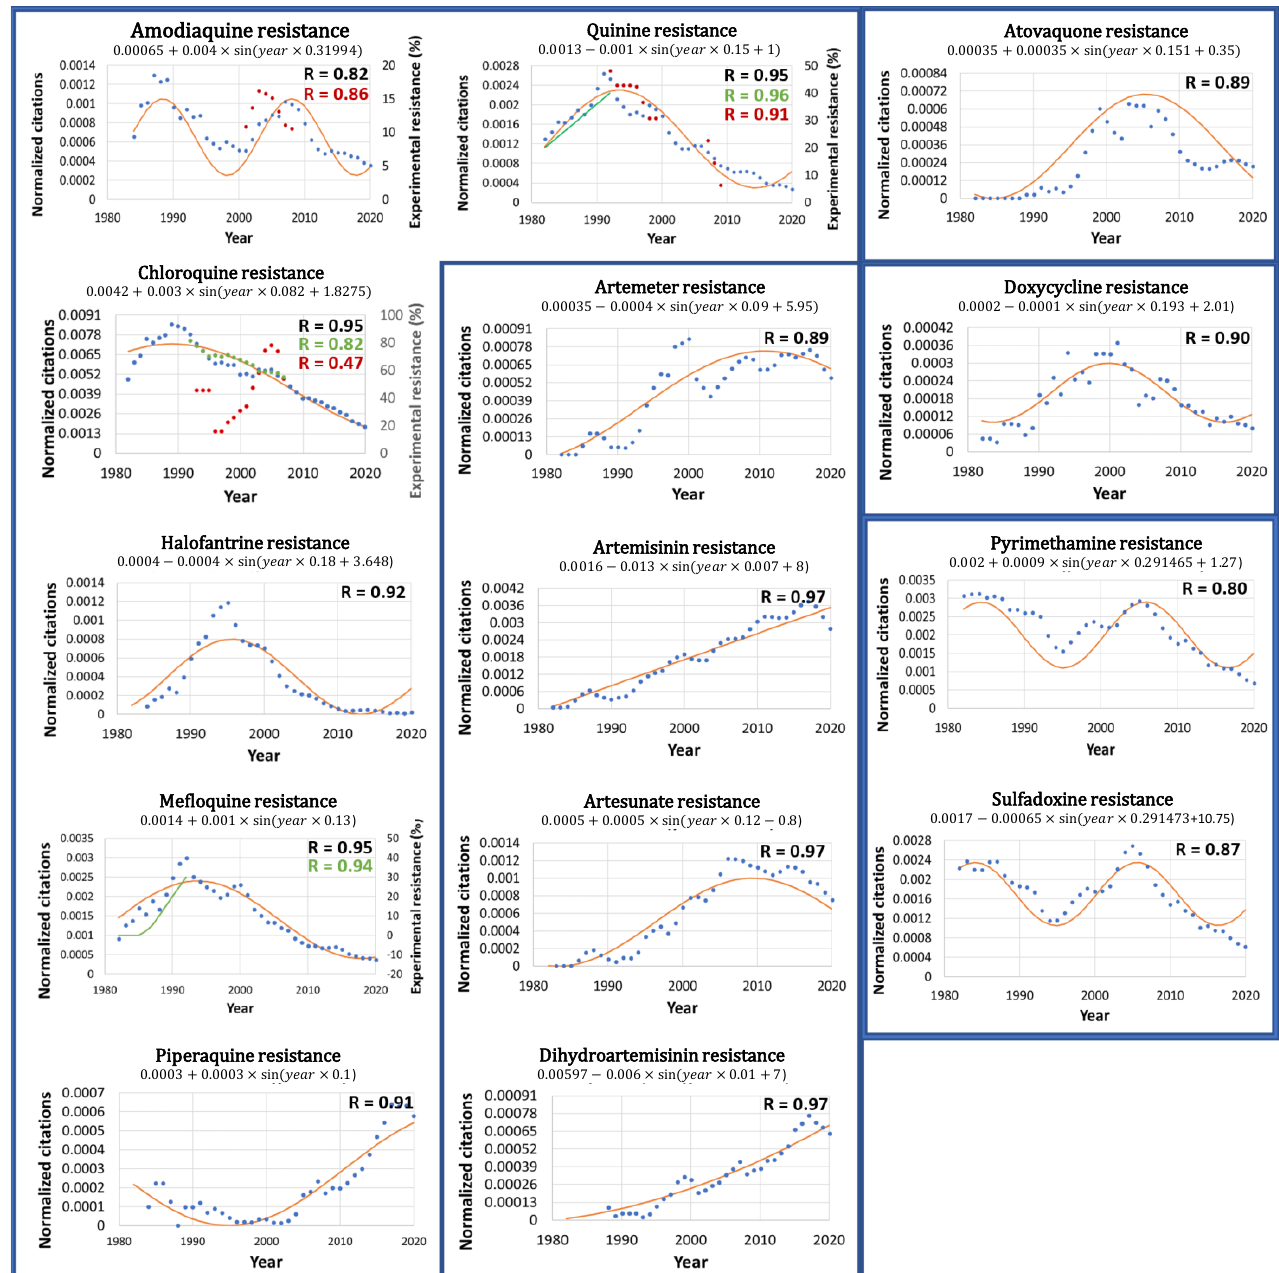
Figure 1. Antimalarial drug resistance is cyclic. The resistance estimated through PubMed citations (blue dots) and the fitted periodic function (red line) are plotted. The fitted equation is listed above each graph, as is the correlation coefficient, R (in black). Notably, antimalarial drug resistance correlates well with sine functions. Artemisinin and dihydroartemisinin also correlate with a linear rise. The clinical monotherapy resistance reported by WWARN 4 is also plotted (red dots), as is the correlation with the PubMed citations, R (in red). Finally, experimental resistance reported by Singhasivanon23 (green line) and Frosch25 (green dots) is plotted, as is the correlation with PubMed citations, R (in green). Notably, the resistance estimated by the normalized PubMed citations correlates well with clinical and experimental data and validates our